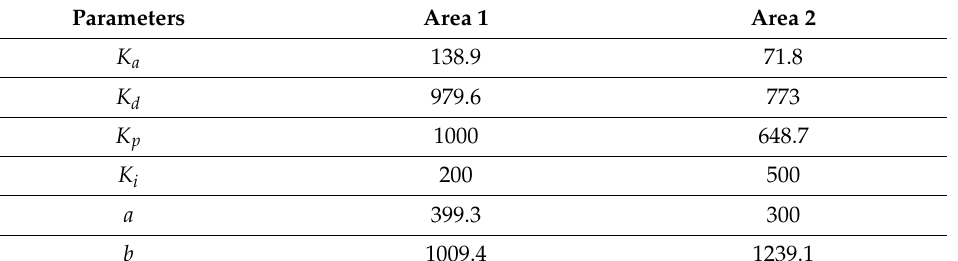
Table 2. The parameters used for the technique presented in [32].